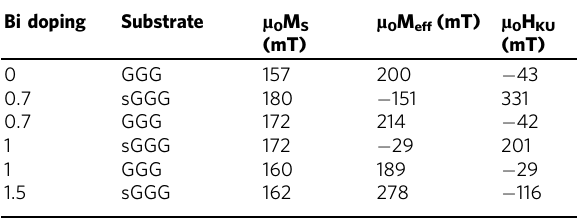
Table 1 Summary of the magnetic properties of Bi x Y 3- x IG fi lms on GGG and sGGG substrates Bi doping